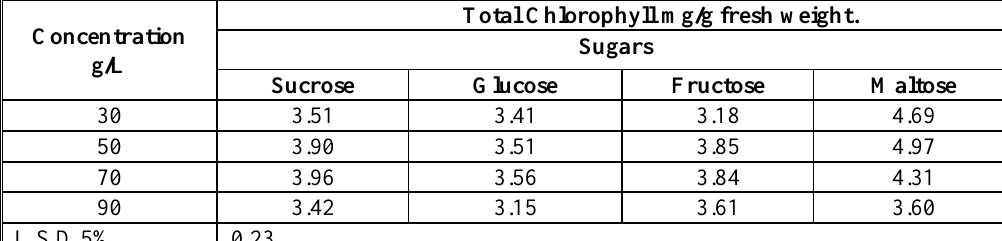
Table 2 : Effect of different concentrations of sugars with the presence of 0.5mg/L TDZ and 2mg/L Cholesterol on total chlorophyll content of multiplied shoots of Digitalis purpurea . Total Chlorophyll mg/g fresh weight.